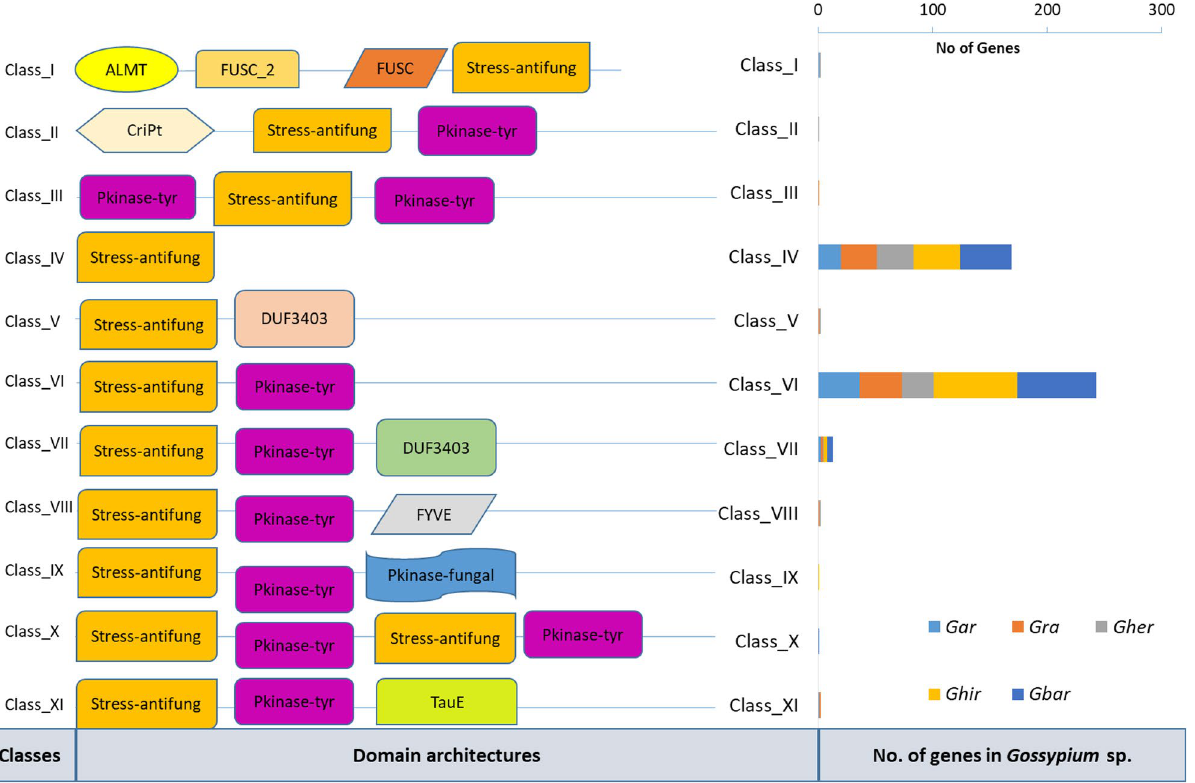
Figure 2. Major classes of CRKs based on 1st classification method and their number of genes in five species G. arboreum ( Gar ), G. raimondii ( Gra ), G. herbaceum ( Gher ), G. hirsutum ( Ghir ), and G. barbadence ( Gbar ).